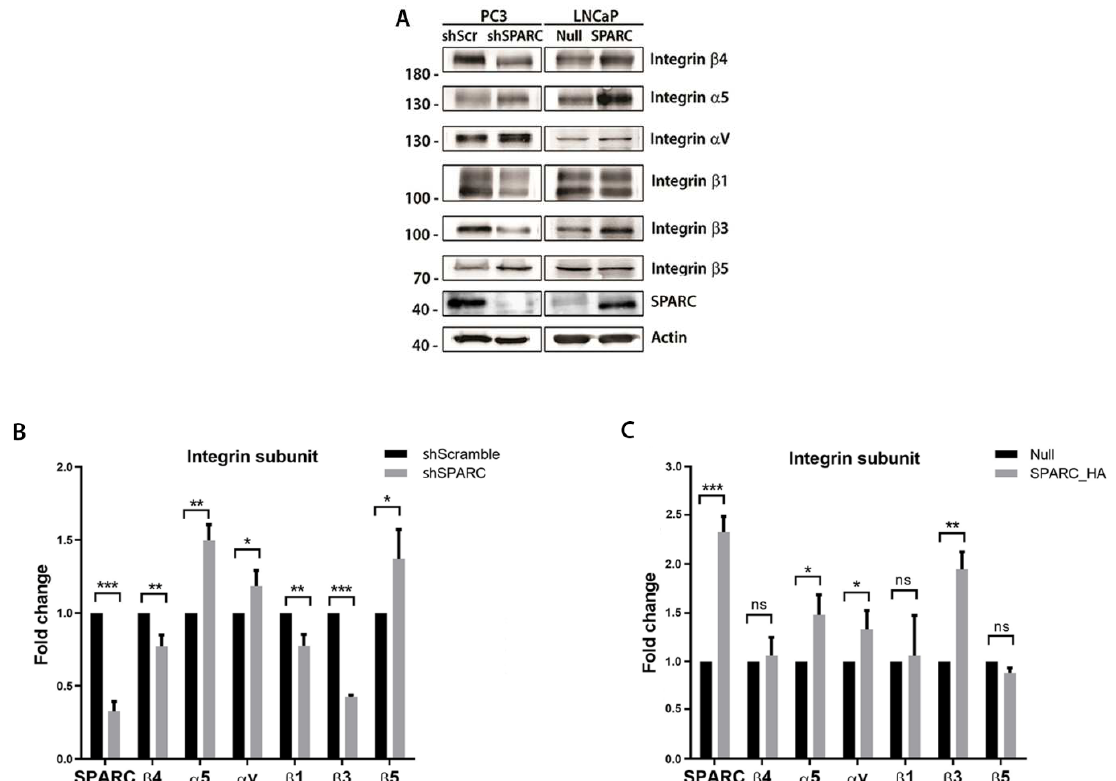
Figure 2. Effect of SPARC on the expression of integrin subunits and the inhibition of E-cadherin ( A ). Representative Western blot of integrin subunits and SPARC expression in PC3 cells transduced with a lentiviral vector carrying a short hairpin RNA against SPARC (shSPARC) or a scrambled sequence (shScr) (left panel) and in LNCaP cells transduced with a lentiviral vector carrying the SPARC sequence (SPARC_HA) or a control vector (null) (right panel) ( B , C ). Quantification of the optic density of the Western blot shown in ( A ). Expression of integrin subunits and SPARC was normalized to β -actin and control cells ( B , C ). Data are expressed as mean ± SD ( n = 3). ns = p > 0.05; * = p ≤ 0.05; ** = p ≤ 0.01; *** = p ≤ 0.001; Mann–Whitney U